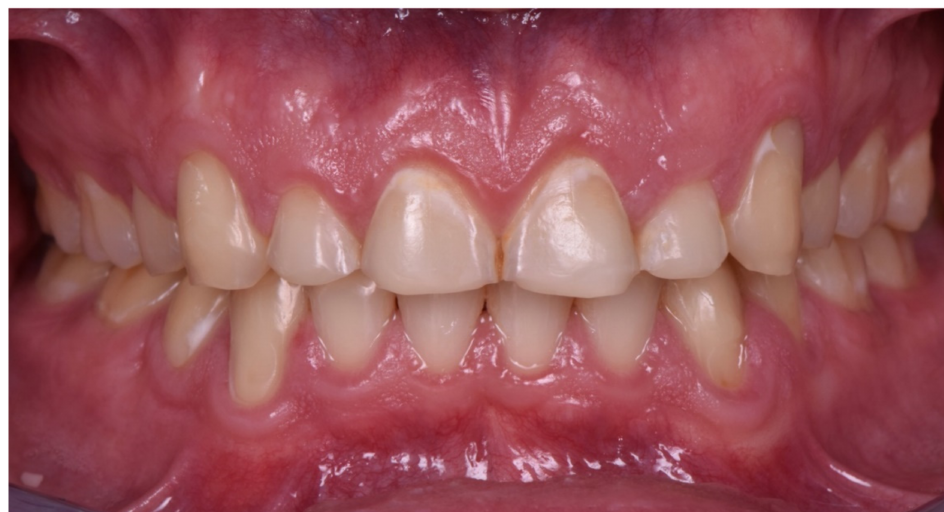
Figure 5. Intraoral picture (front).